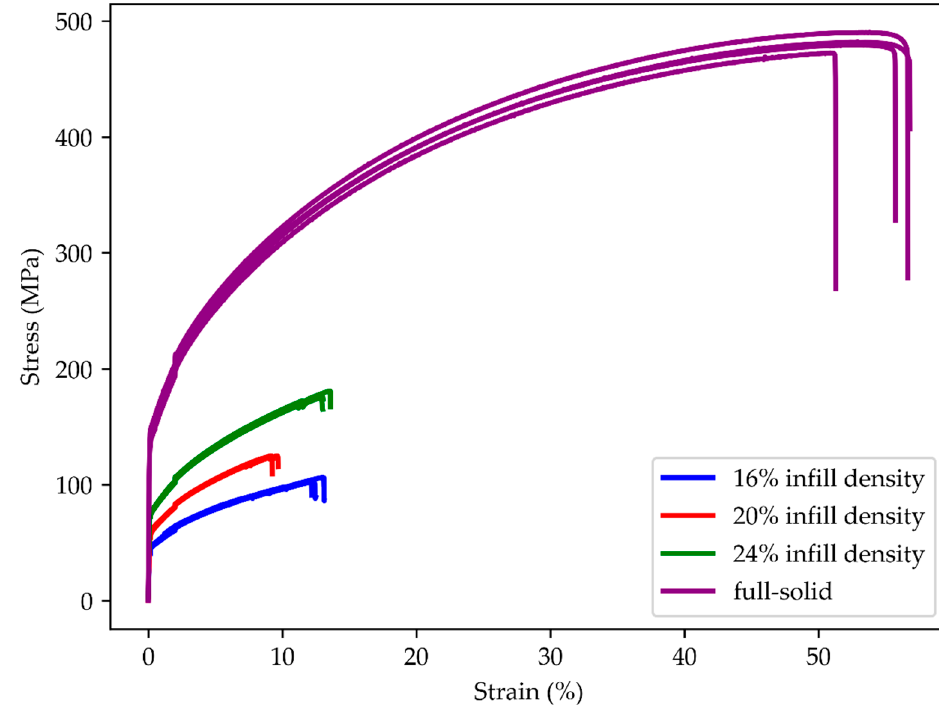
Figure 10. The comparison of stress–strain curves between infill and full-solid specimens made from 316L stainless steel.